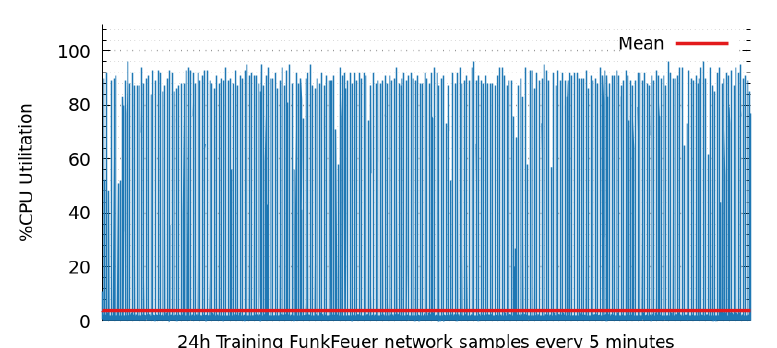
Figure 19. CPU utilization for Training WEKA model every 5 min in a period of 24 h: mean CPU utilization is about 3.78%.